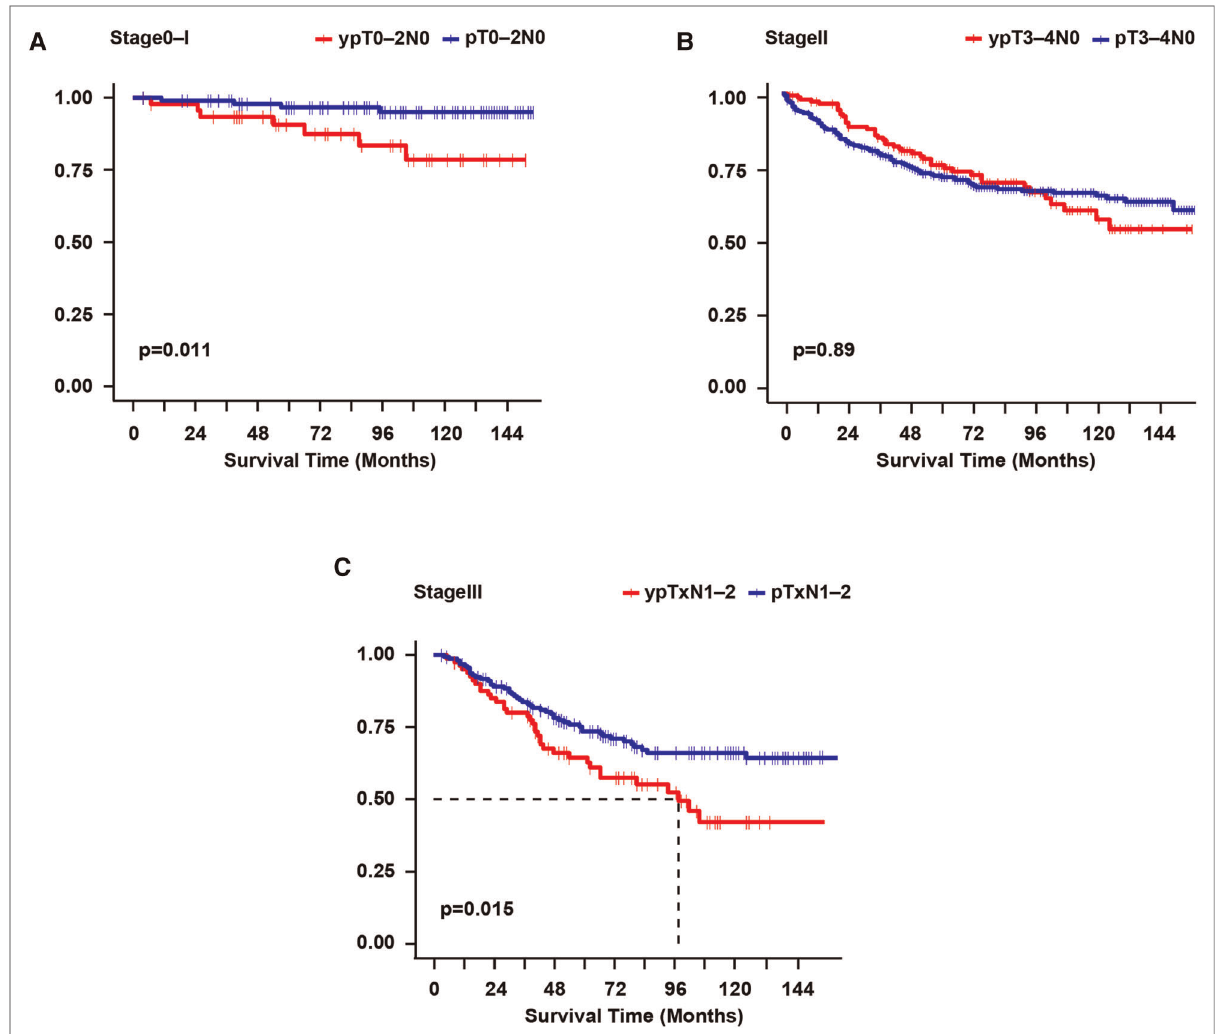
FIGURE 3 Survival curves were constructed per the Kaplan-Meier method for cause-speci fi c survival for each pathological stage. Log-rank test for p -value. ( A ): yp stage 0-I vs. p stage 0-I; ( B ): yp stage II vs. p stage II; ( C ): yp stage III vs. p stage III. yp, the fi nal pathological stage after neoadjuvant chemotherapy; p , pathological